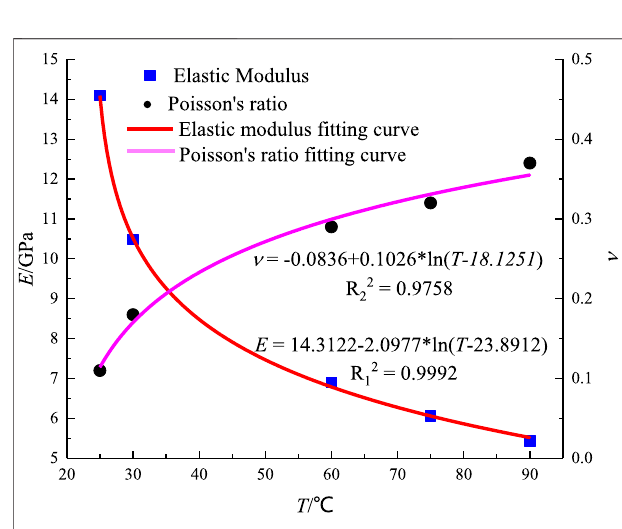
FIGURE 9 | The relationship between temperature and elastic modulus, Poisson ’ s ratio of sandstone under triaxial compression.